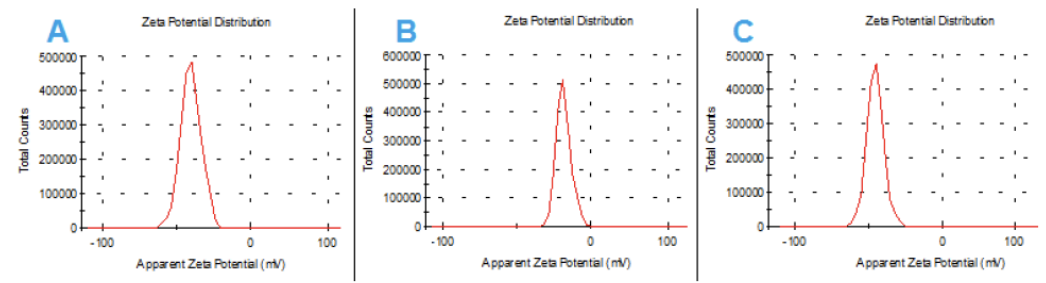
Figure 3. Zeta potential distribution for ( A ) ND-SQ1, ( B ) ND-SQ2, and ( C ) ND-SQ3.